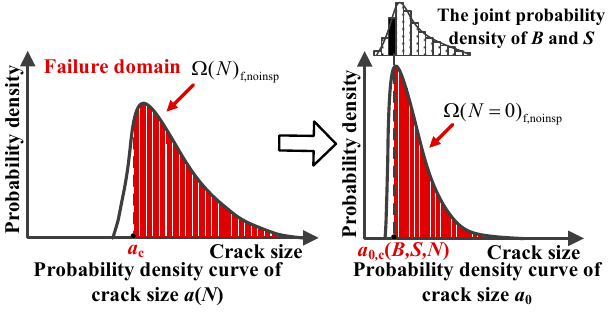
Figure 4. Schematic diagram of probability space transformation under multi variables.